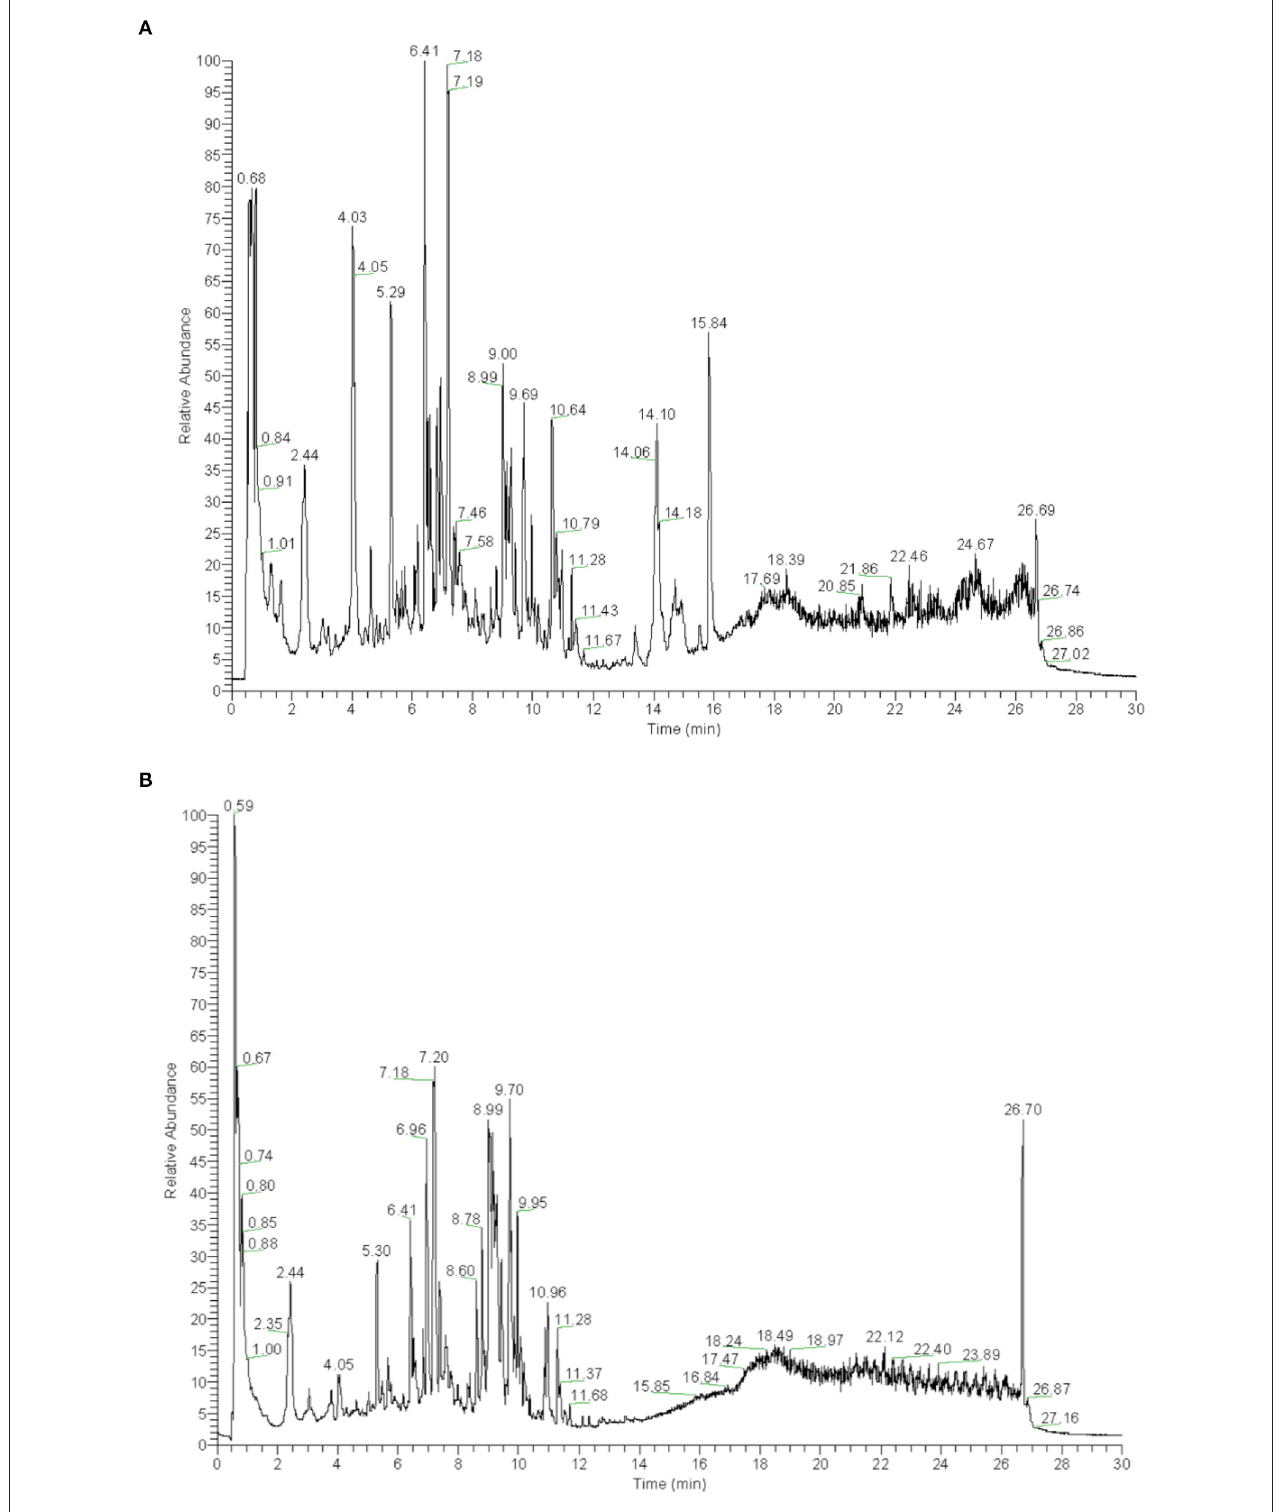
FIGURE 3 | (A) UHPLC-QTOF-MS analysis base peak intensity chromatograms of YS in positive mode. (B) UHPLC-QTOF-MS analysis base peak intensity chromatograms of YS in negative mode.